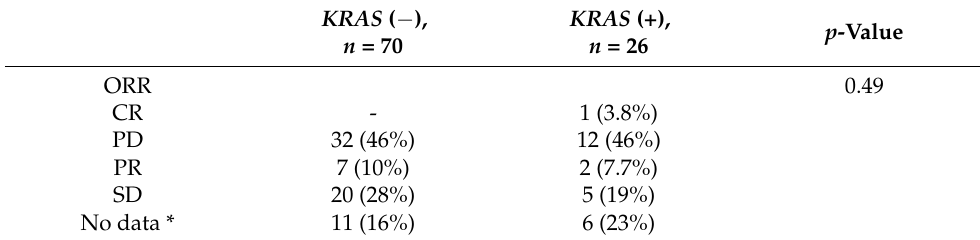
Table 2. Response to treatment by KRAS mutation status.